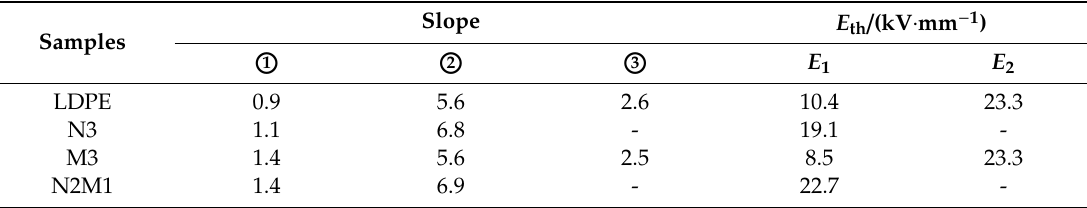
Table 3. Conductance current slope and transition threshold electric field ( E th ) of LDPE and ZnO / LDPE composites.